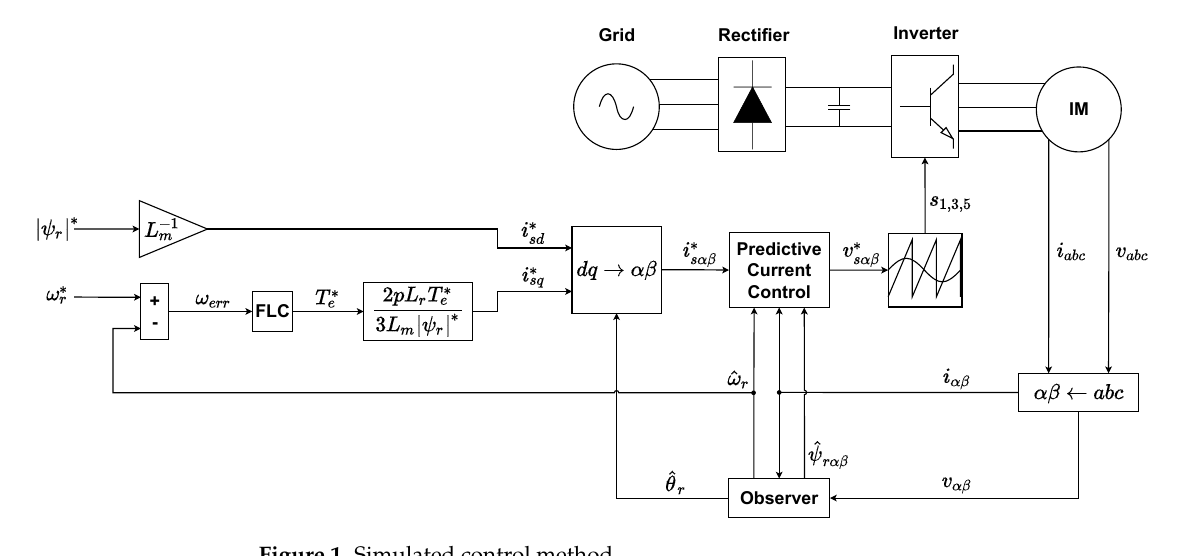
Figure 1. Simulated control